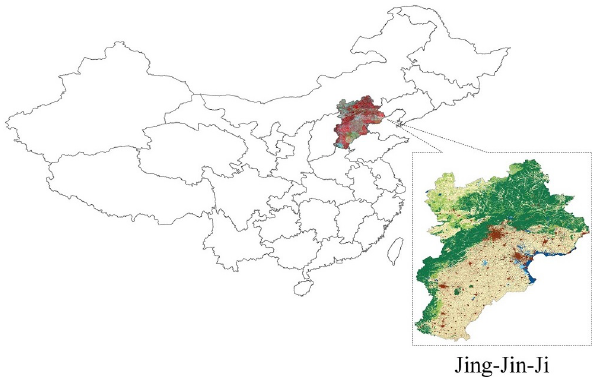
Figure 1. Location of the Jing-Jin-Ji region within